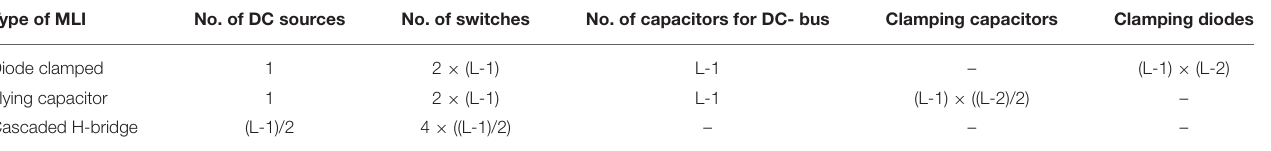
TABLE 2 | Required number of components for traditional